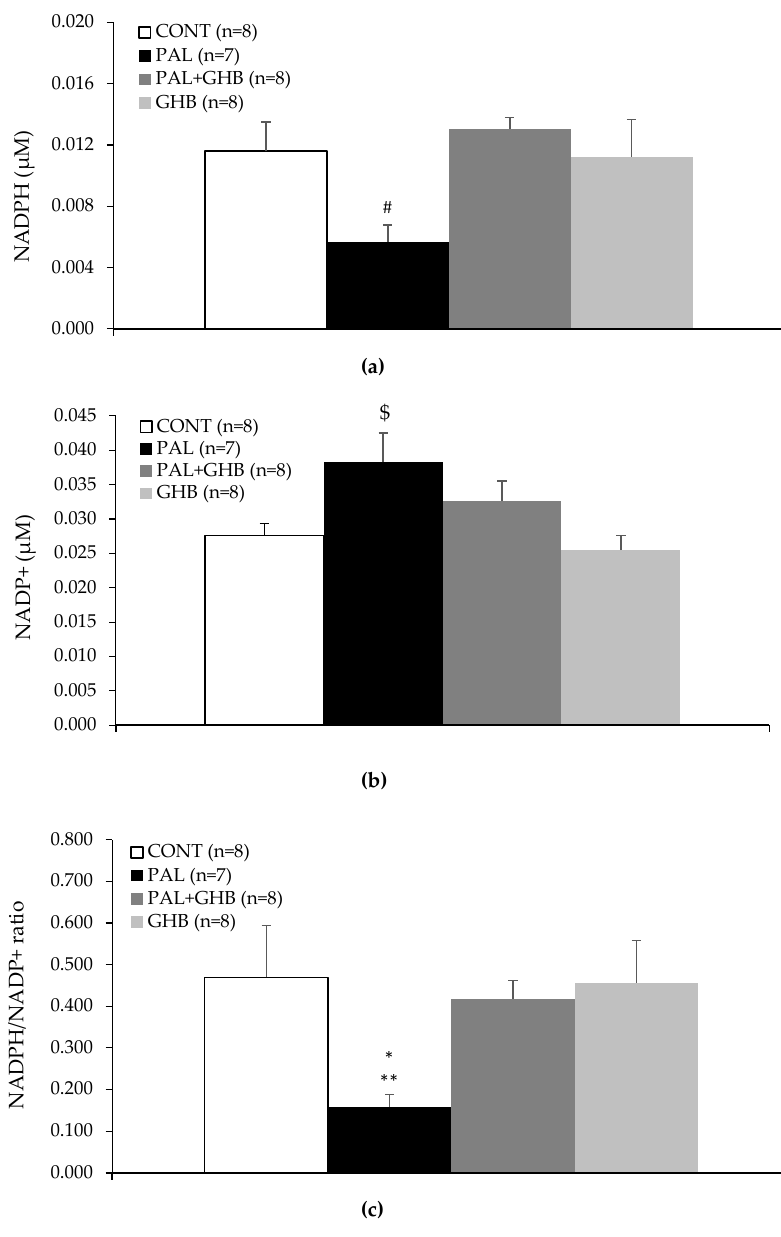
Figure 4. Effects of palmitate and gamma-hydroxybutyric acid (GHB) on NADPH and NADP+ in mouse islets. Islets were treated for 48 hrs with (1) control media, (2) Palmitate (0.4 mM), (3) Palmi- tate (0.4 mM) and GHB (5 mM), and (4) GHB (5 mM) alone. ( a ) NADPH measurement in islets. ( b ) NADP+ measurement in islets. ( c ) NADPH/NADP+ ratio in islets. Palmitate treatment